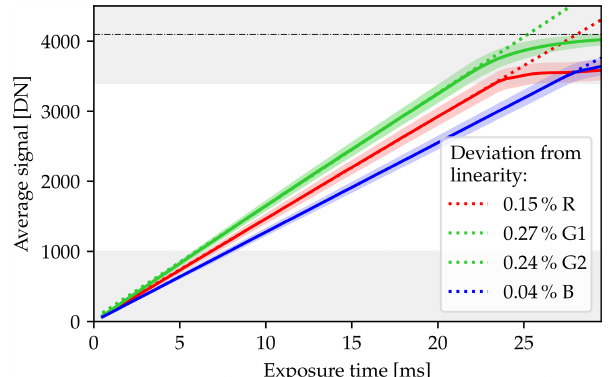
Figure 8. HaloCam RAW relative spectral response for the R, G1, G2, and B